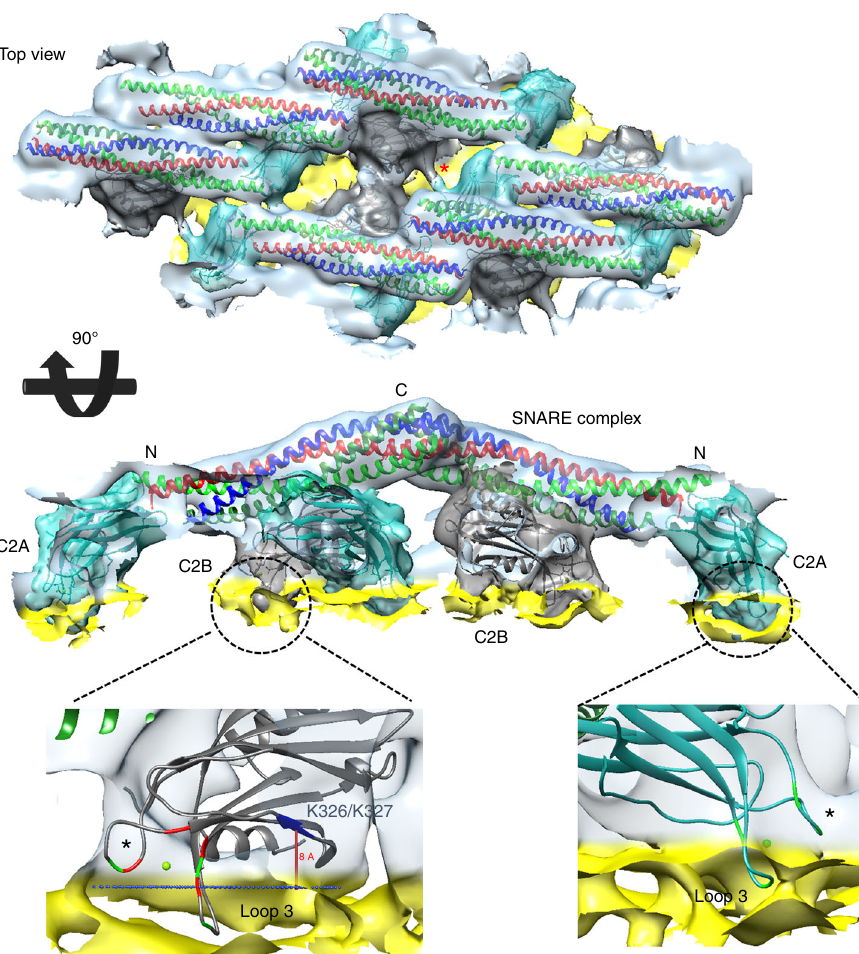
Fig. 2 Organization of Syt1 C2AB – SNARE on a lipid membrane surface. The rigid body docking of single C2A, C2B, SNARE crystal structures from Syt1 C2AB – SNARE 3D crystal (5CCI) onto the Cryo-EM map. SNAREpins (multi-color) form the top-most protein layer and are positioned in antiparallel fashion with their C-terminus pointing away from the membrane (yellow). The Syt1 C2B domains (gray) are positioned between SNAREpins and the outer membrane ’ s phospholipid heads plane. The linker between the C2A (cyan) and C2B domain is extended and clearly visible (red asterisk) allowing unambiguous identi fi cation of C2A and C2B domains within the same Syt1 C2AB unit. Both C2 domains adopt a previously unseen orientation relative to the membrane surface. One of the Ca 2 + -coordinating aliphatic loops (loop 3) on both C2 domains is partially inserted into the phospholipid heads plane, while loop 1 (black asterisk) stays close to the lipid surface. The conserved polybasic patch (residue K326/327 in blue) in the C2B domain is also positioned close to the lipid head group, suggesting possible